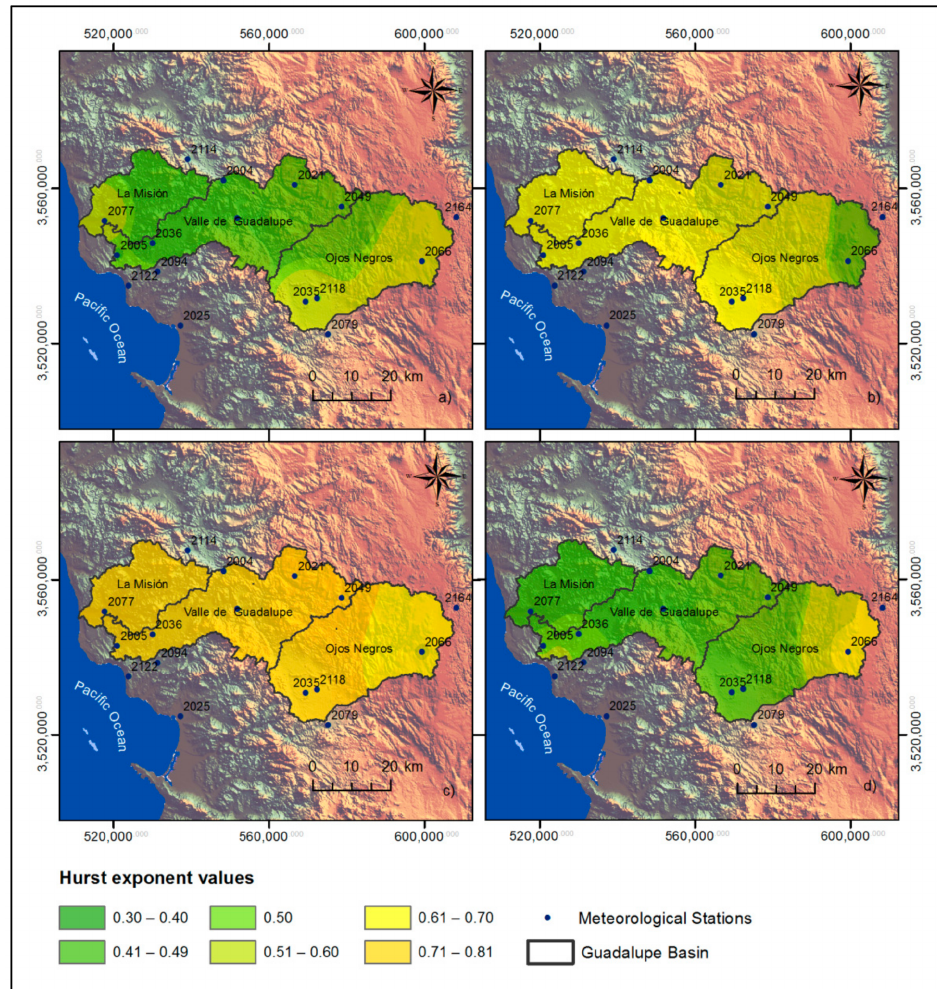
Figure 7. Maps of the Hurst exponent for the time series made up of days with Santa Ana winds and for the variables of ( a ) temperature, ( b ) pressure, ( c ) relative humidity, and ( d ) wind